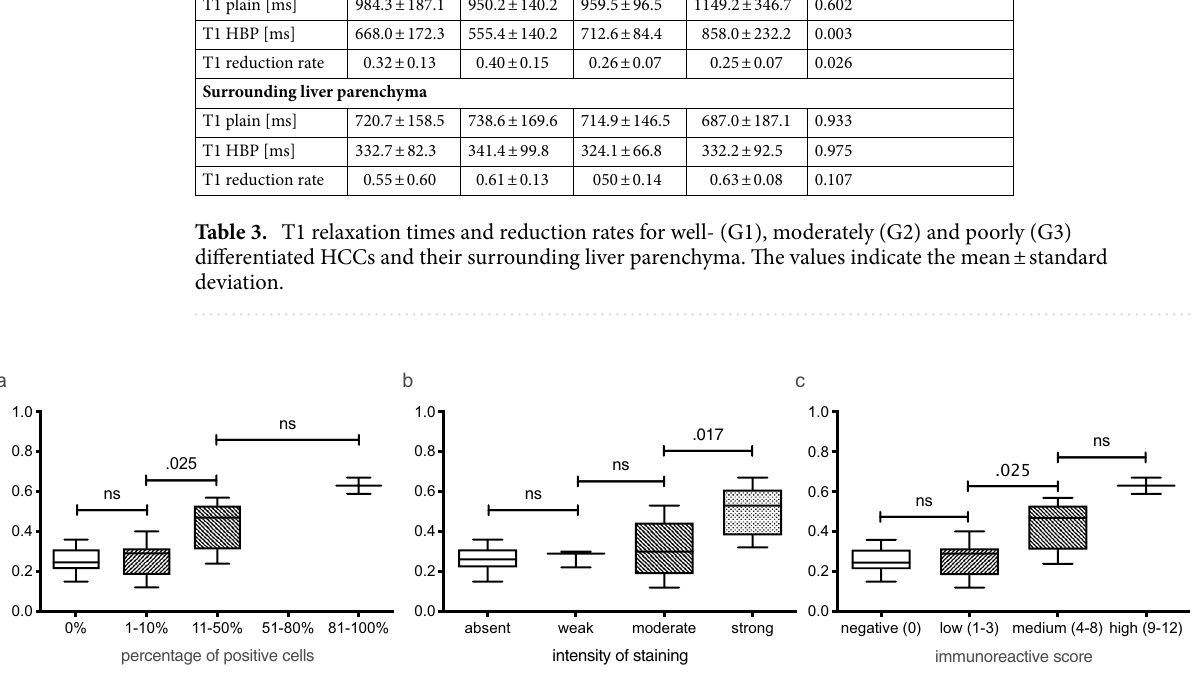
Figure 4. Boxplot of the tumor reduction rate in the hepatobiliary phase in comparison to immunostaining results of OATP1B3. Tumor reduction rate between the plain and hepatobiliary phases in comparison to the percentage of positive cells ( a ), the intensity of staining ( b ) and the resulting immunoreactive score ( c , multiplication of a and b ). Data presented as box plots follow standard Tukey representations. The Kruskal– Wallis test was used to compare the